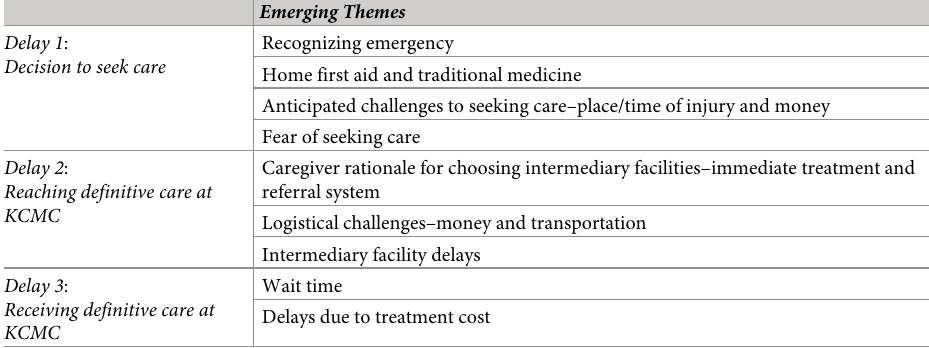
Fig 2. Frequency of injured pediatric patients by first health facility. This figure shows the frequency of injured pediatric patients by first health facility where they received treatment. It represents both those that survived (grey) and those that died (black). https://doi.org/10.1371/journal.pgph.0000657.g002 Table 2. Themes relating to the three delays for pediatric injury